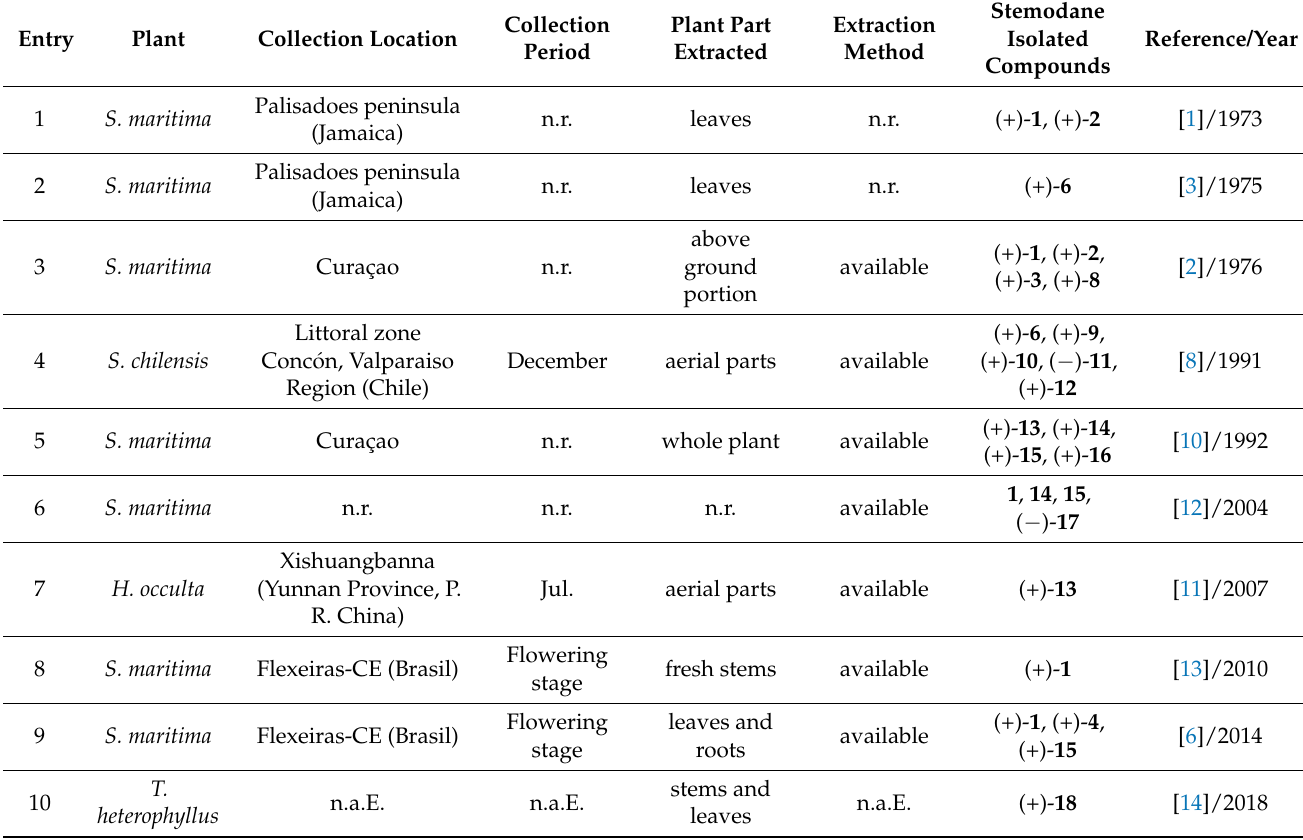
Table 1. Summary table for compounds isolated from S. maritima, S. chilensis, Homalomena occulta, Trigonostemon heterophyllus (n.r. = not reported; n.a.E. = not available in English).